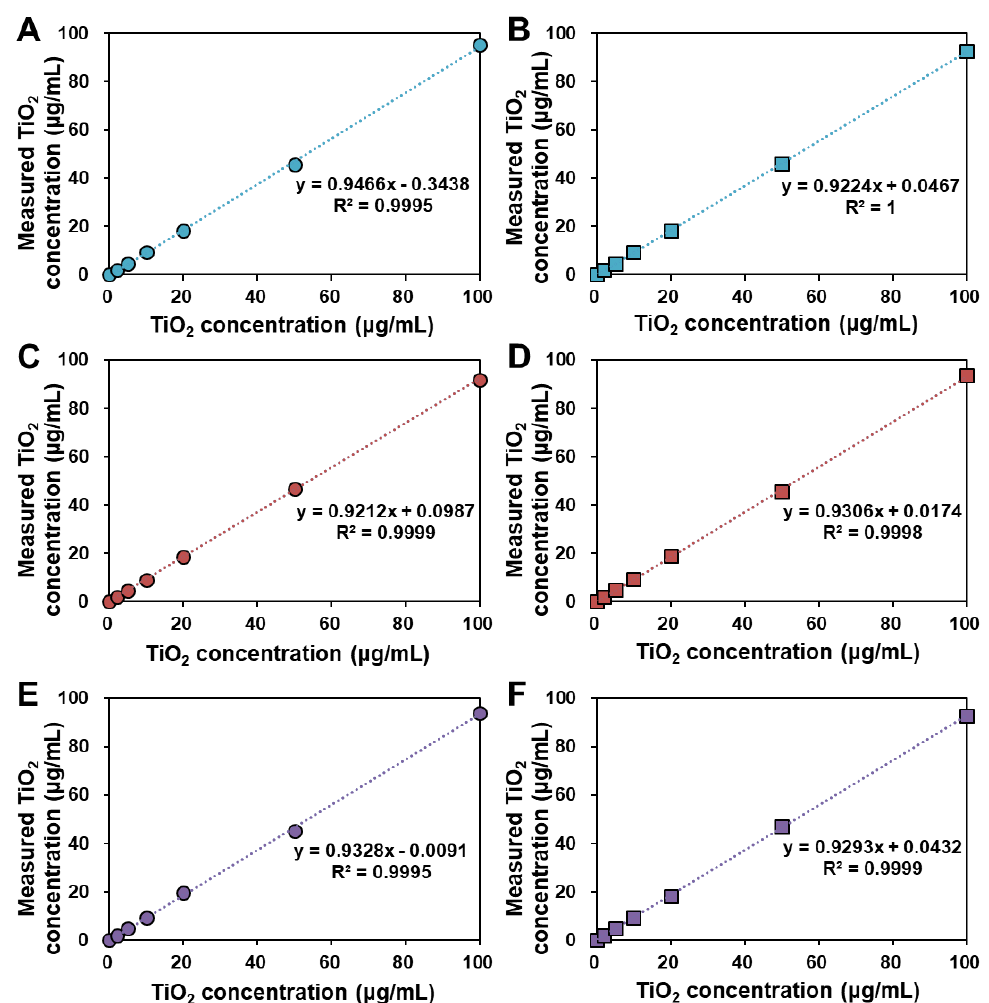
Figure 3. Calibration curves for determination of ( A ) pristine T3 and ( B ) pristine T4, ( C ) T3 and ( D ) T4 in simulated sugar powder, and ( E ) T3 and ( F ) T4 in simulated gum by inductively coupled plasma-atomic emission spectroscopy (ICP-AES) analysis. Table 4. Analytical recovery, limit of detection (LOD), and limit of quantification (LOQ) of quantitative analytical procedure for TiO 2 .